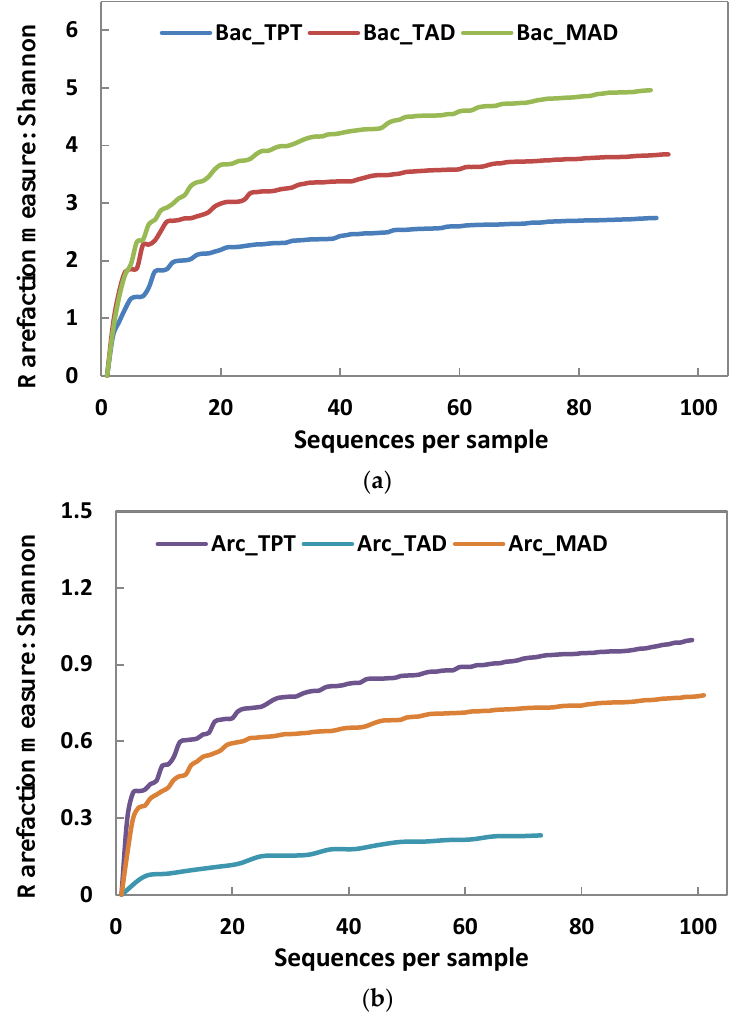
Figure 1. Shannon rarefaction curves of ( a ) bacterial and ( b ) archaeal clone libraries. Table 2. Operational taxonomic units (OTUs) and α-diversity indices of bacterial and archaeal clone libraries.